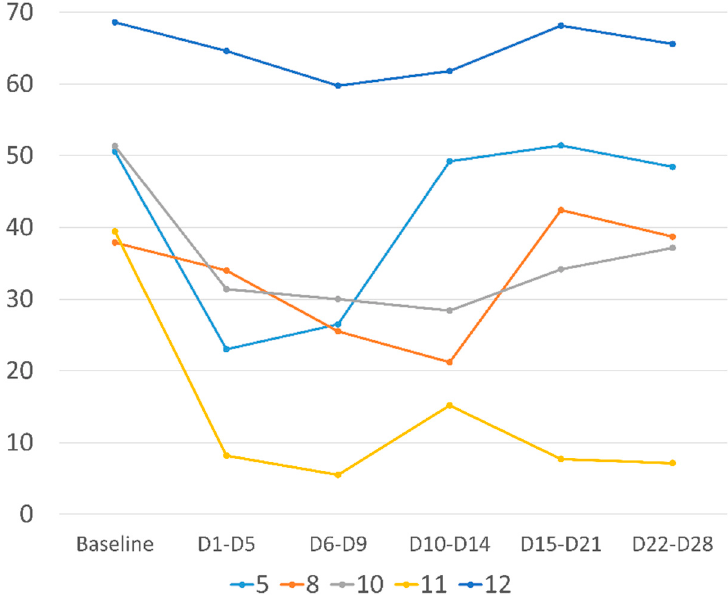
Figure 2. Evolution of daily pain over time for the five patients with more than 10% reduction at day 8 (D8), day 1 corresponding to the first rTMS session. Pain is noted out of 100.